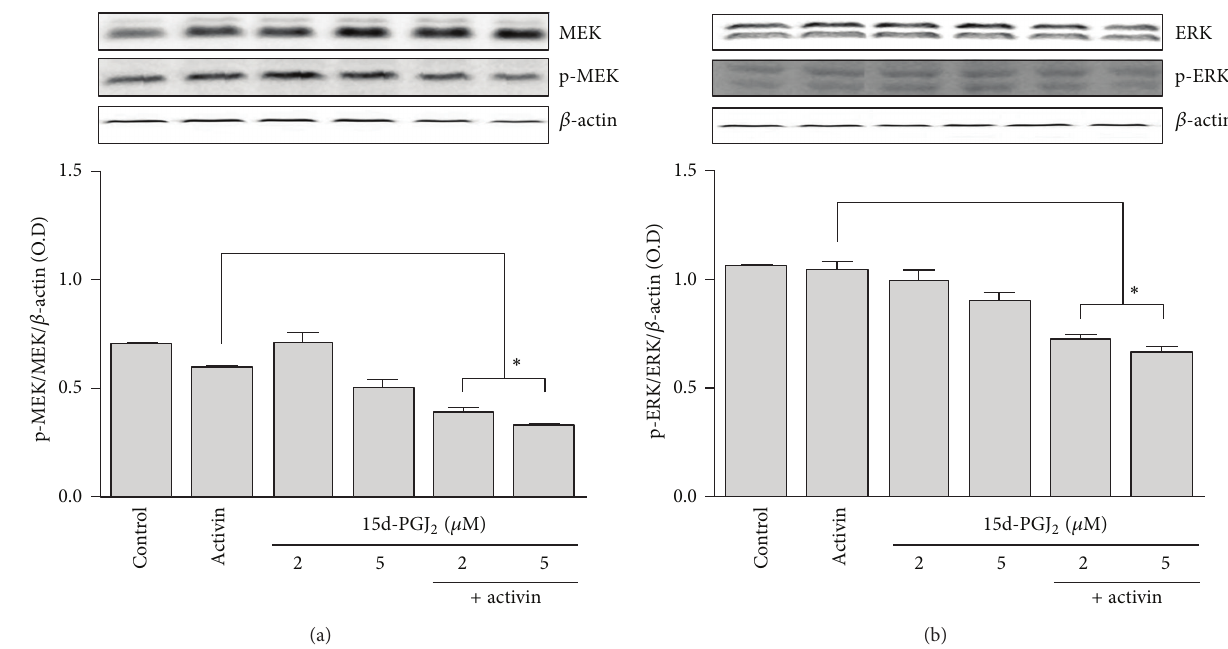
Figure 5: MEK and ERK protein expression in HepG2 cells. HepG2 cells were cultured with activin A (25ng/mL) and 15d-PGJ 2 (2 or 5 𝜇 M) for 72 h. The cells were lysed, and 30 𝜇 g of soluble protein was separated by performing electrophoresis on a 12% SDS-PAGE gel. Protein was detected by performing western blot analysis. The protein band intensities were quantified by using the i -image solution program, and the results are reported as the ratio of MEK (a) and ERK (b) to 𝛽 -actin. The data represent the mean ± SD of 3 independent samples. ∗ 𝑃 < 0.05 , comparison of stimulation with 15d-PGJ 2 and activin A versus activin A stimulation